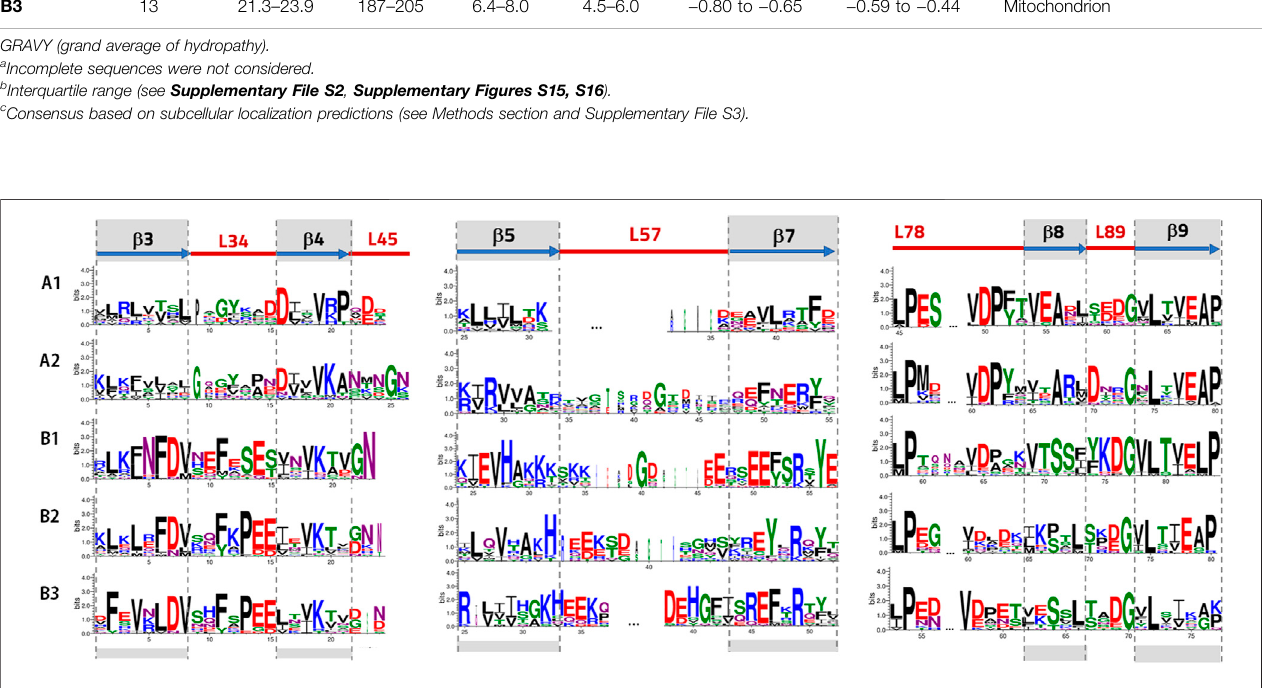
Frontiers in Physiology |